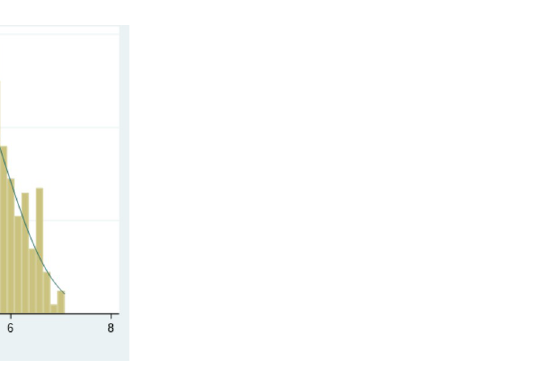
Fig 2. Psychological safety scores (range one to seven) in the latest supervised patient encounter among European medical students with normal curve (n = 886).